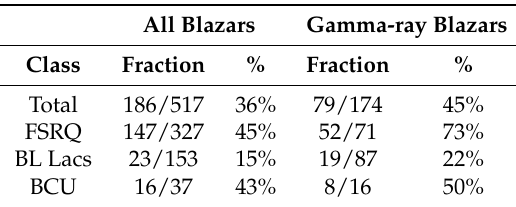
( a ): Cumulative distribution function for the low frequency spectral index of the entire MWACS catalogue (red line) and the blazar subset (blue line); ( b ): Gamma-ray energy flux at E > 100 MeV vs. 120 MHz flux density (main panel) or upper limits (side histogram). Adapted from [25]. Reproduced with permission from Astronomy & Astrophysics, c (cid:13) ESO. Table 1. Detection rates of blazars in the